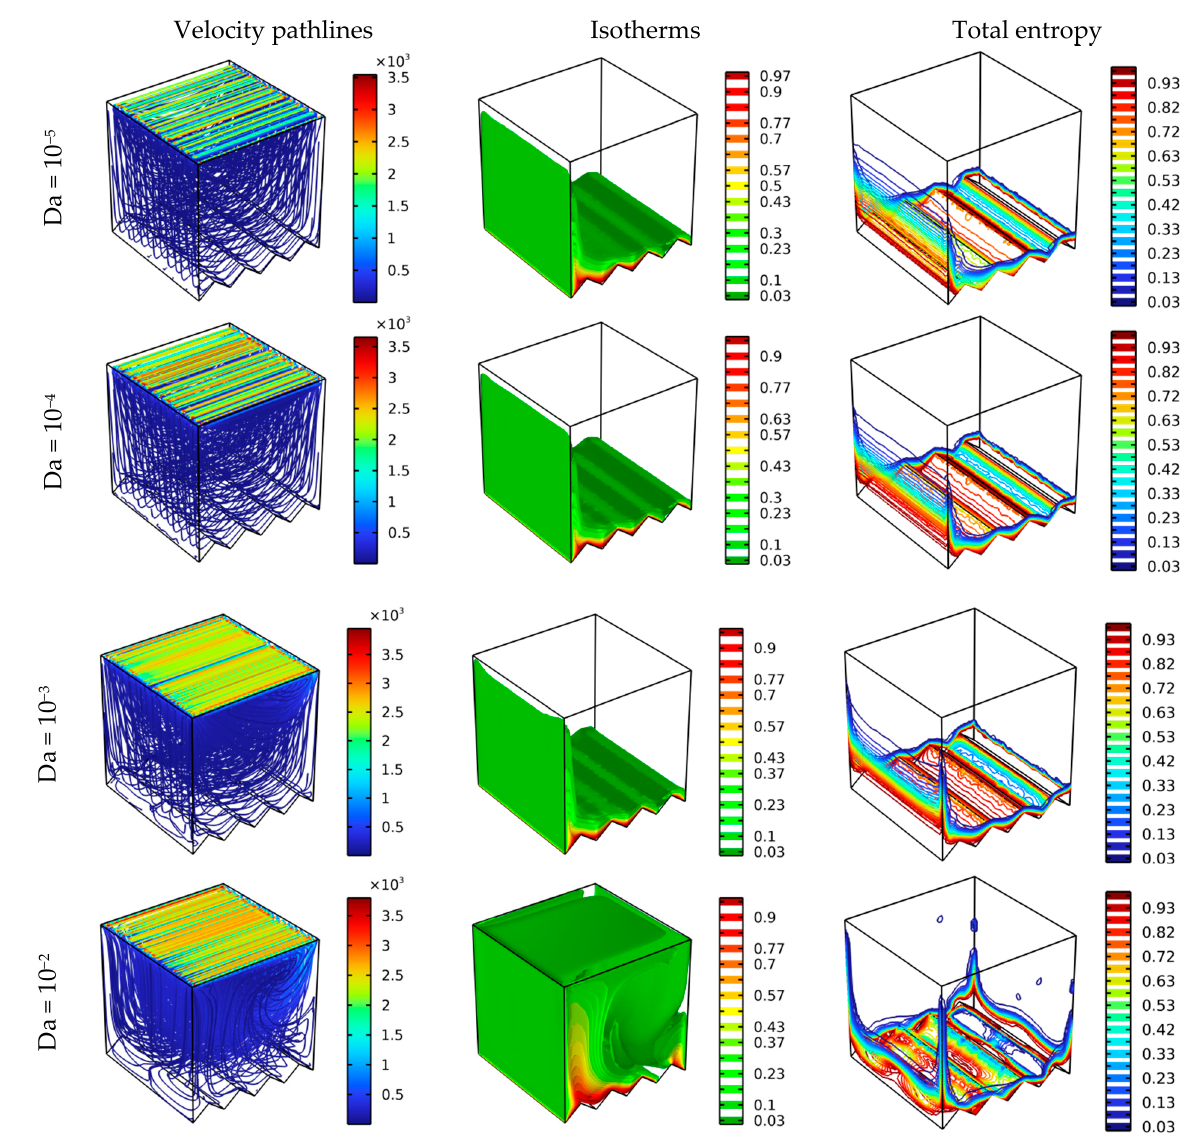
Figure 3. Velocity pathlines, isotherms, and total entropy for different Da at various scenarios for Ha = 0, φ = 0.04, and Re = 100.